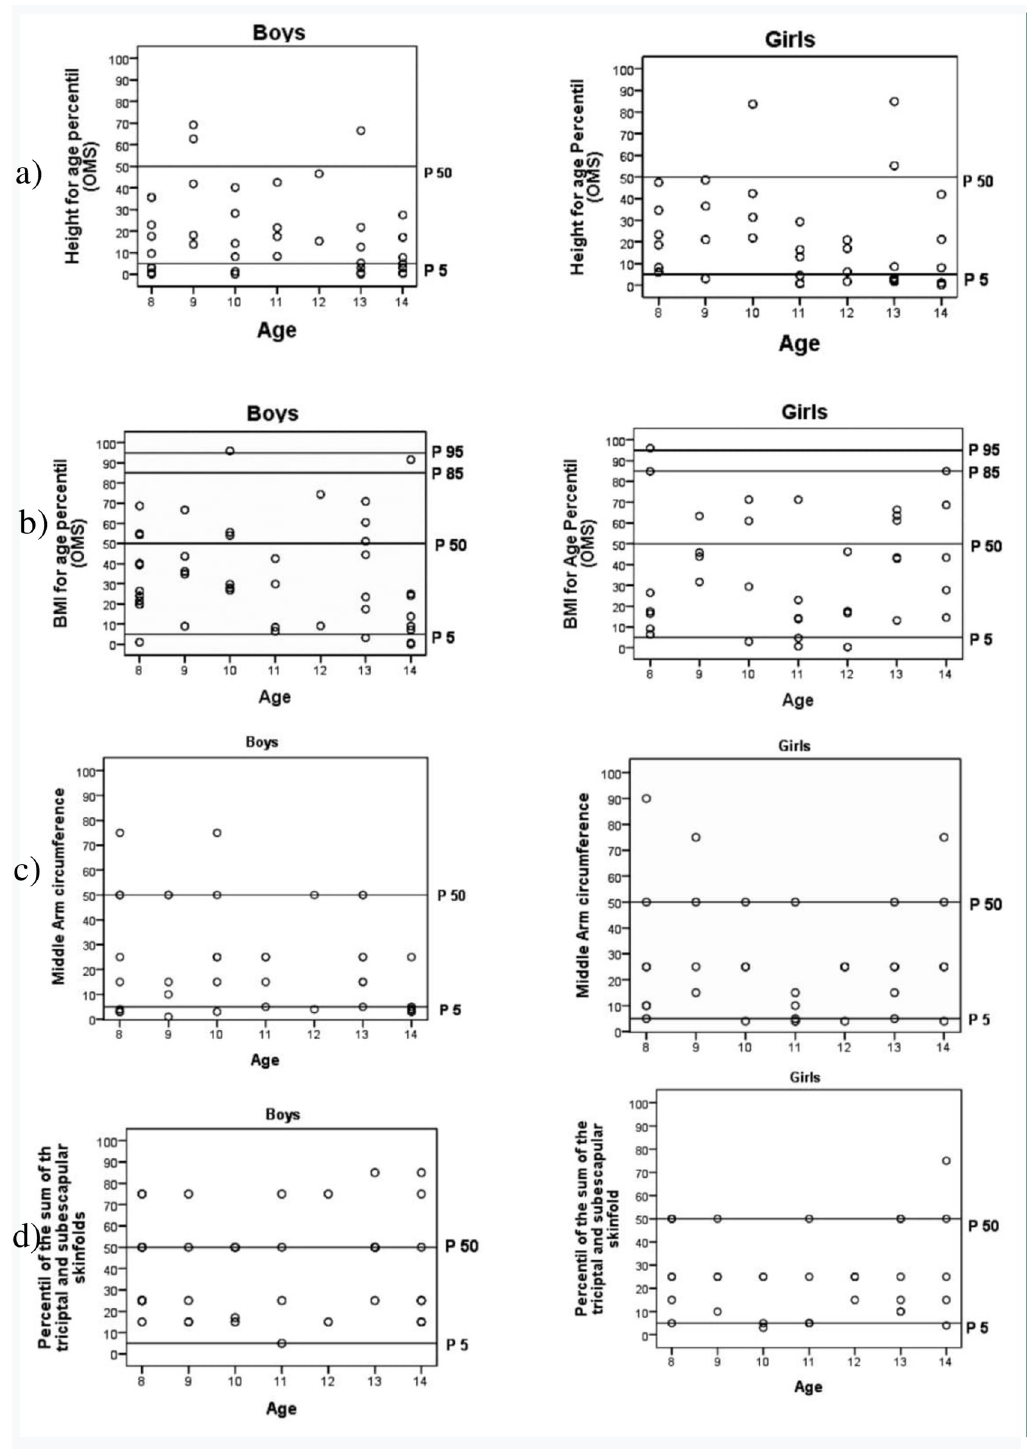
Fig 1. Individual position of each subject relative to reference standards in a) height/age and gender, b) BMI/age and gender, c) MAC/age and gender and d) sum of skinfolds/age and gender.